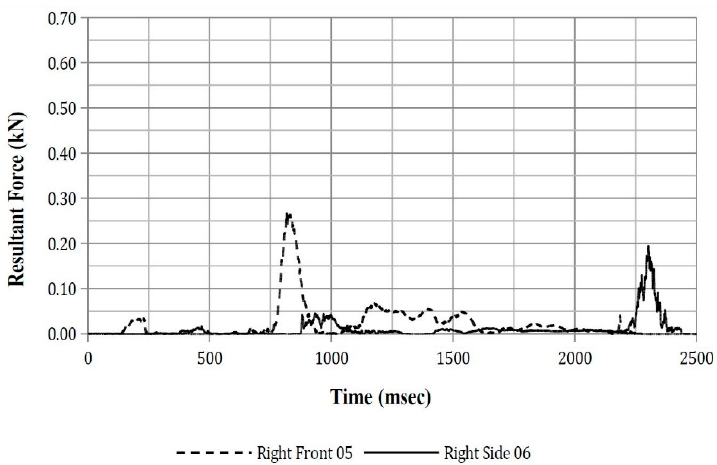
Figure A26. ATD Position 1 thorax resultant force.